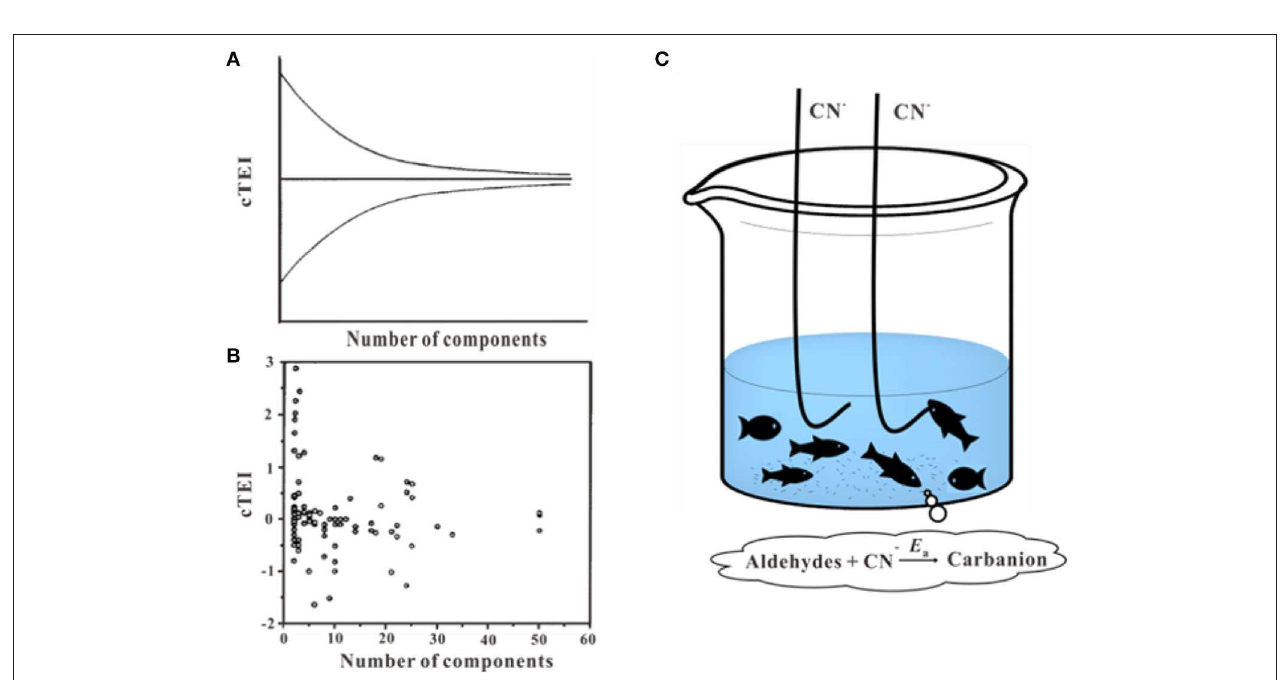
FIGURE 8 | Funnel hypothesis and fishing hypothesis. (A,B) Toxicity enhancement index values (cTEI) plotted against the number of components in the mixtures (Warne and Hawker, 1995). (C) Schematic of the fishing hypothesis (Li et al., 2014). Adapted and modified with permission from Warne and Hawker (1995) and Li et al. (2014)